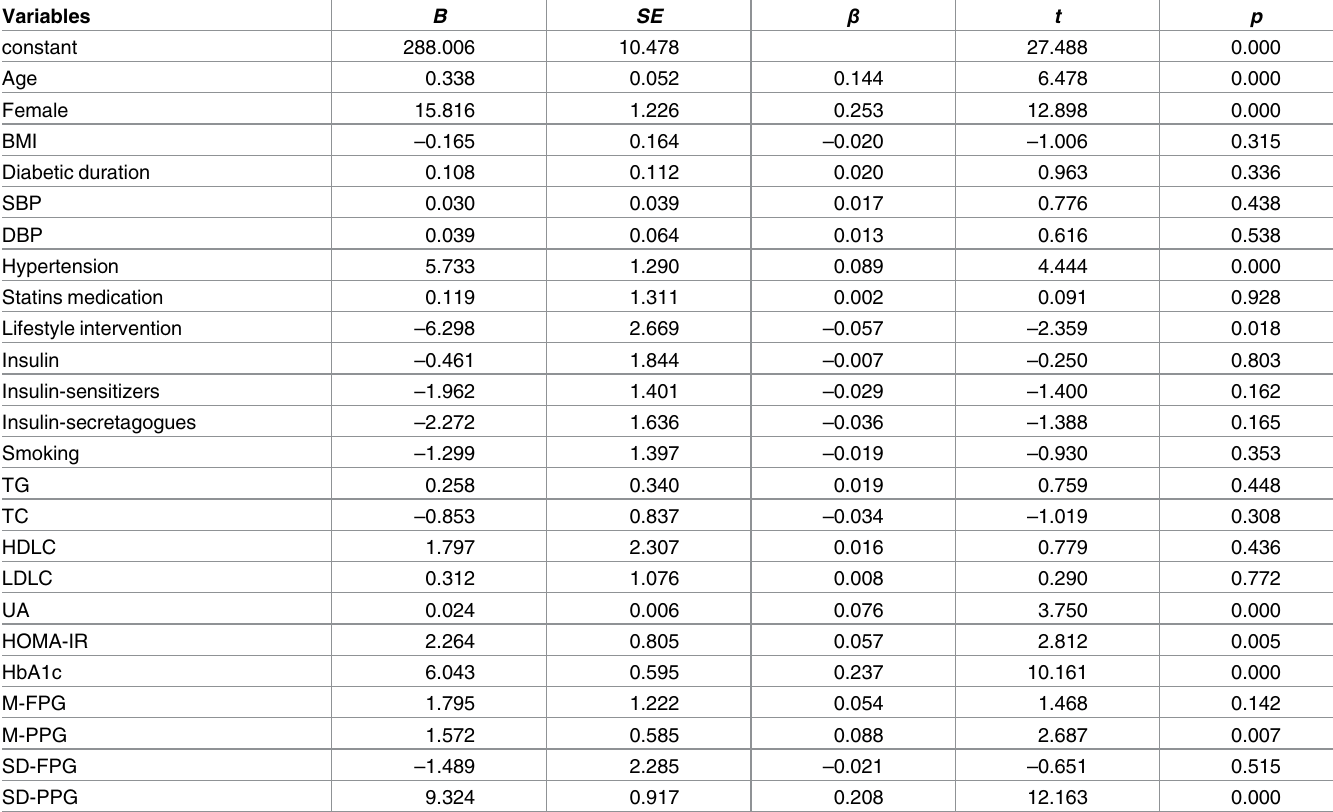
Table 2. Multiple linear regression analysis with QTc interval as the dependent variable in participants.